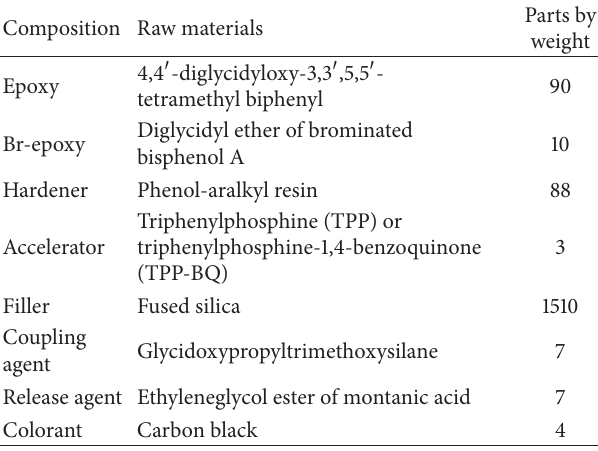
Table 1: Formulation of epoxy molding